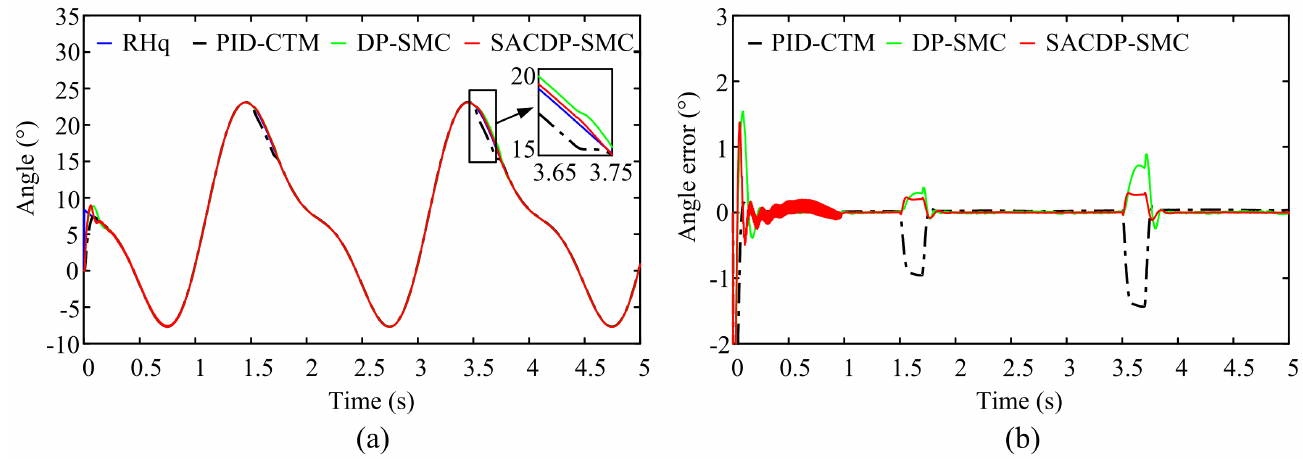
Figure 5. The tracking curve and error of the right hip. ( a ) The tracking curve of the right hip; ( b ) The tracking error of the right